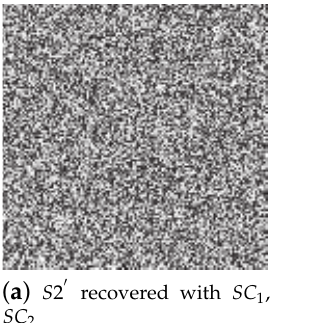
; ( b – e ) recovered binary 1 by stacking and XORing; ( f ) recovered 1